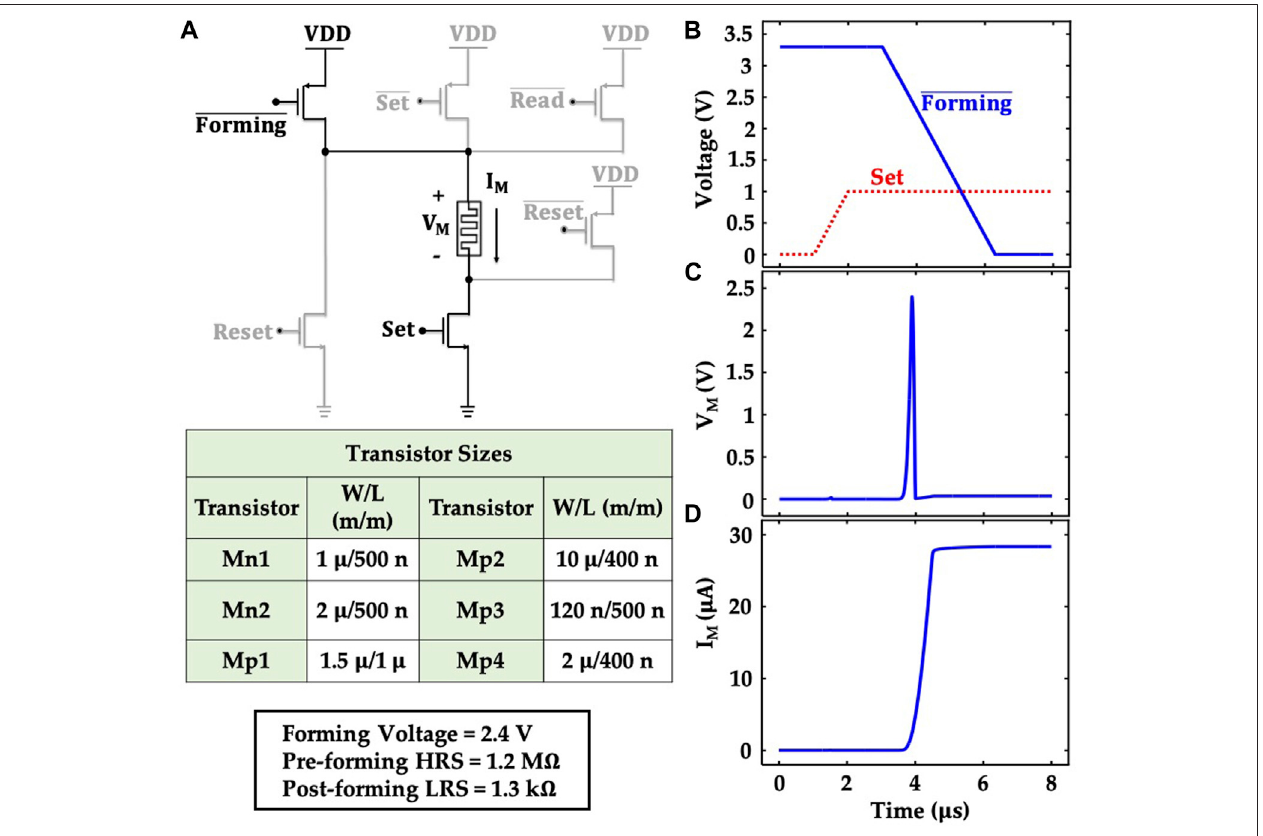
FIGURE 4 | (A) Schematic of the memristor-based synapse circuit that can control forming, set, reset and read operations in a memristor device. In this work, the set, reset and readout portions of the circuit are greyed out (unused). (B) Time dynamics of the input signals ( (cid:2) Forming and Set) to control the forming process. Time dynamics of (C) memristor voltage ( V M ), and (D) memristor current ( I M ) for the applied input signals.